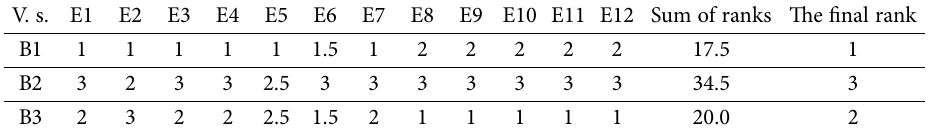
Table 3. Ranking factors in the group of value for the consumer regarding the commercial potential of technologies V. s. E1